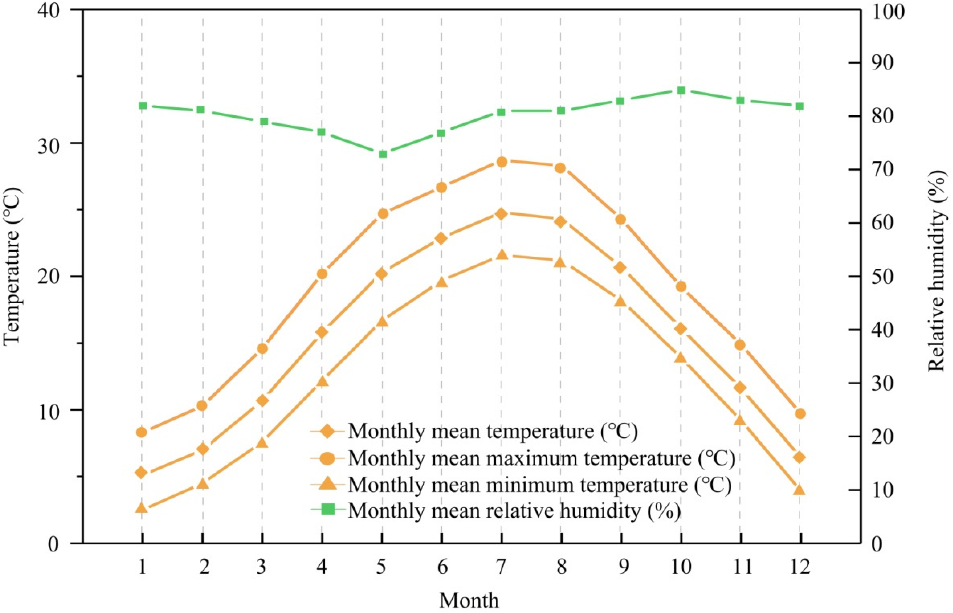
Figure 4. Map of historical meteorological data of Dujiangyan city.